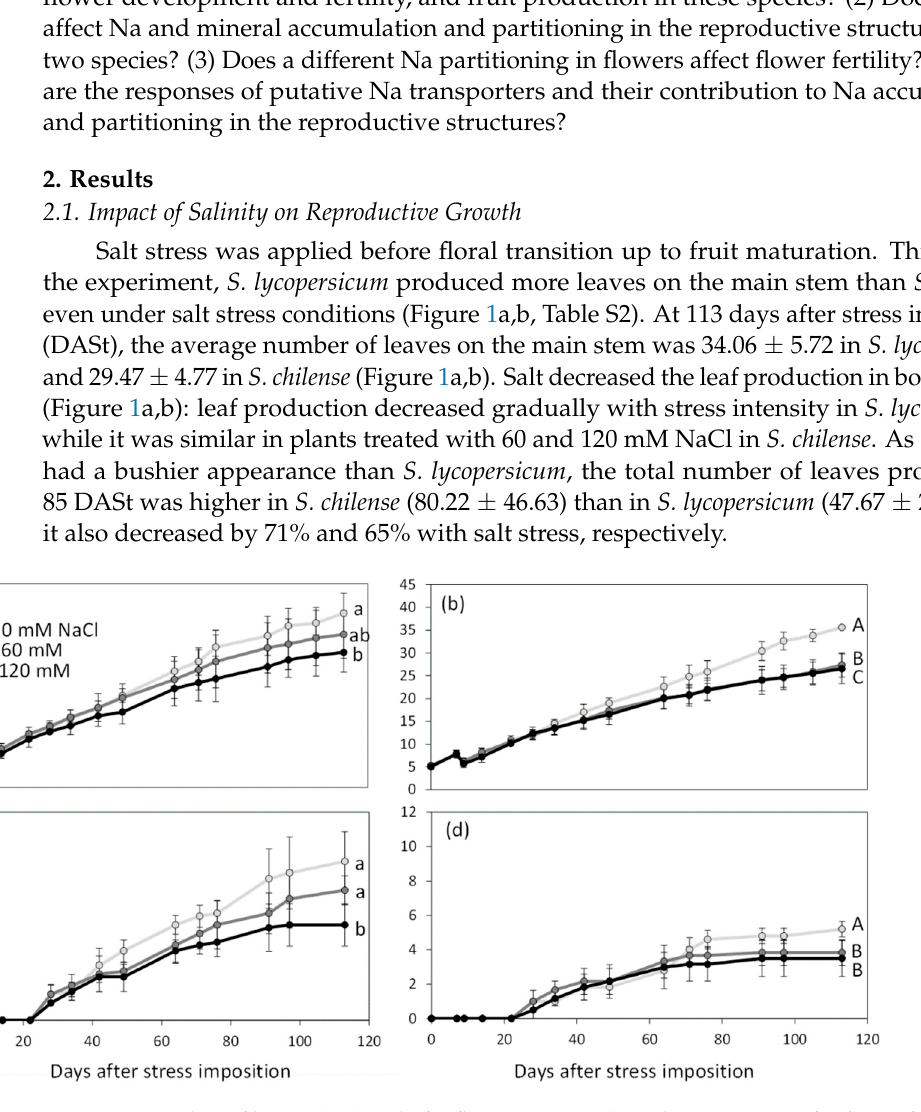
Figure 1. Number of leaves ( a , b ) and of inflorescences ( c , d ) on the main stem of Solanum lycopersicum ( a , c ) and Solanum chilense ( b , d ) grown in perlite:vermiculite mixture supplied with 0, 60, and 120 mM NaCl from 0 to 113 days after stress imposition. Data are means ± SD, treatments followed by different letters are significantly different (lowercase, S. lycopersicum , uppercase, S. chilense ) at p < 0.05 for a same species at 113 DASt.